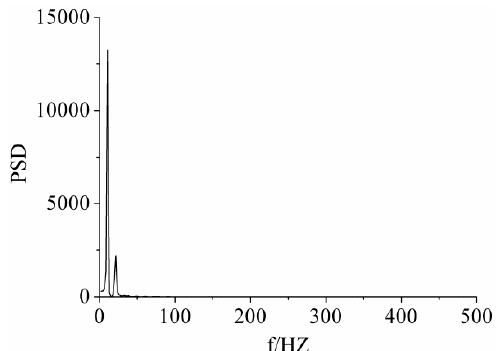
Figure 6. Acoustic power spectral density at U7 for σ = 1.075.